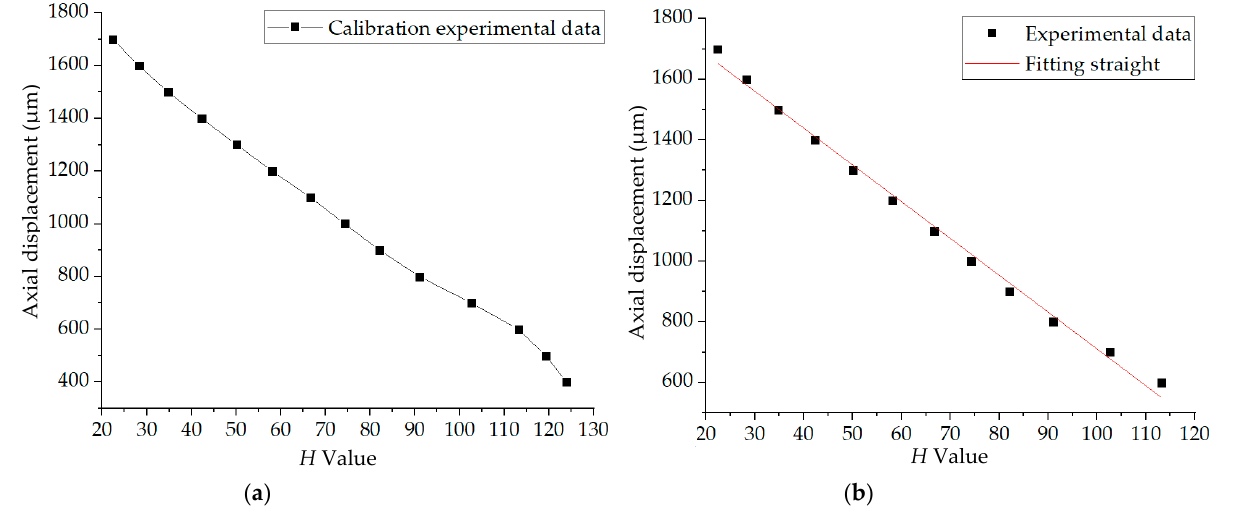
Figure 11. ( a ) Calibration experiment result. ( b ) Linear fitting result. Table 2. Calibration result calculated using the data from the upper surface of the slide.